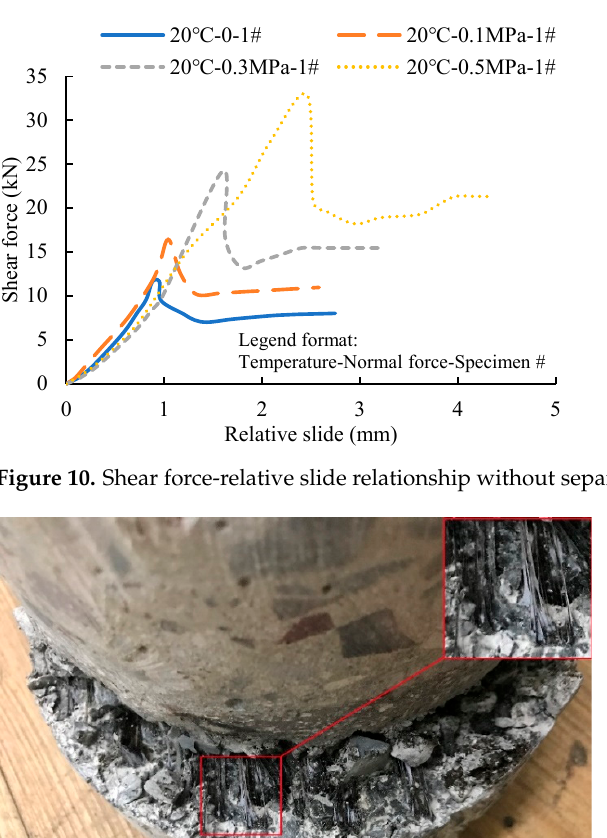
Figure 9. Shear force-relative slide relationship with separator layer.